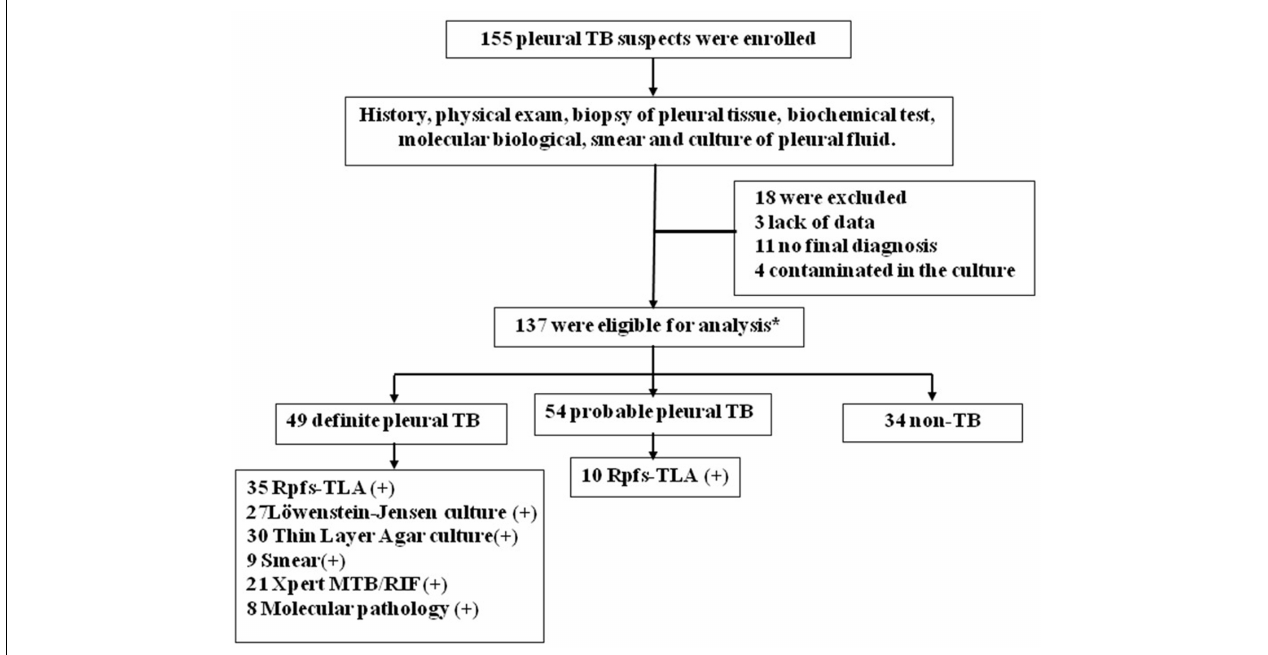
FIGURE 1 | Flowchart of the study population. *Patients who were classified according to composite reference standard criteria that does not include. TB, tuberculosis; Xpert, Xpert MTB/RIF; Rpfs-TLA, resuscitation-promoting factor-based thin layer agar; Smear, acid-fast bacilli smear microscopy.